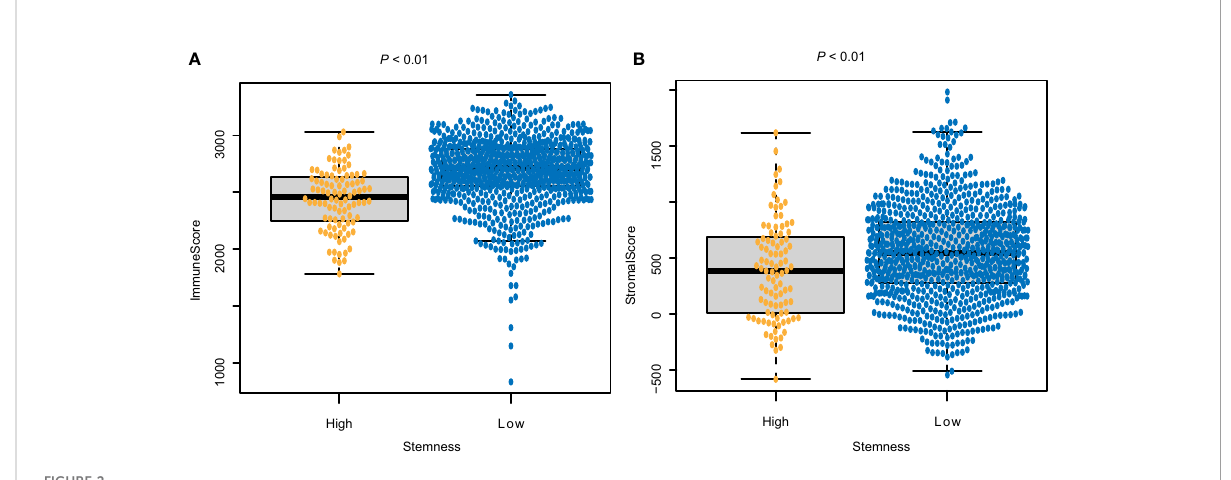
FIGURE 2 Correlations between the degree of stemness and (A) Immune score; and (B) stromal score.